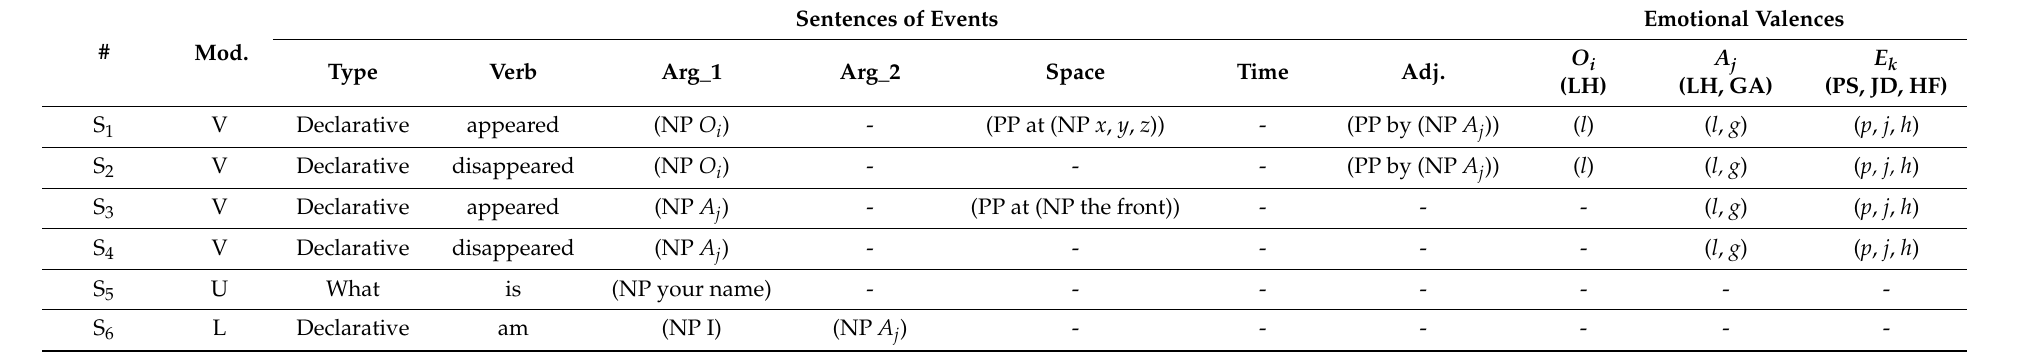
Table 4. Event and emotional valence. Each event occurs in a module and the objects, agents, and events have their own emotional valence according to (1)–(4). (Mod.: Modules, Arg_1: 1st Argument, Adj.: Adjunction, O i : i th object, A j : j th agent, E k : k th event; S1: 1st sentence; l , g , p , j , and h : emotional valences of LH, GA, PS, JD, and HF respectively; V: vision module, L: listening module, U: utterance